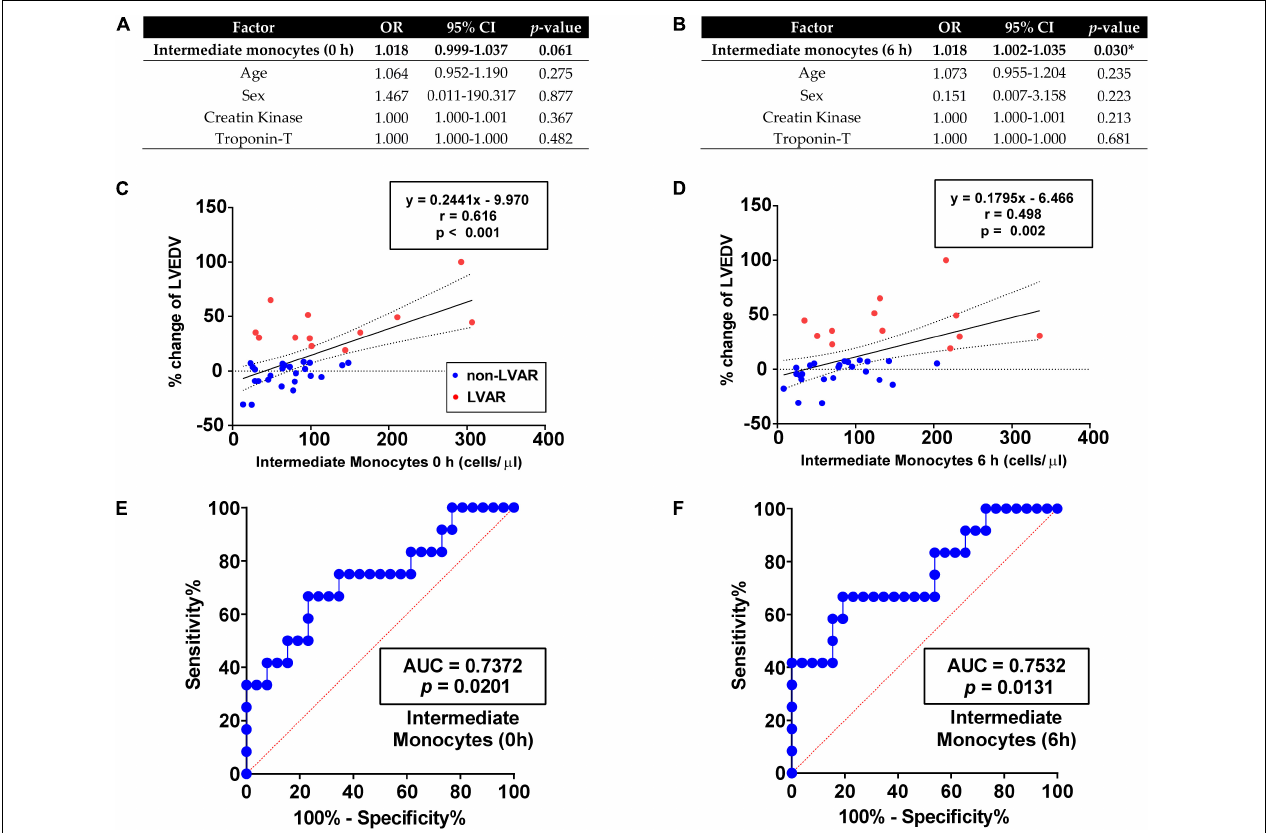
FIGURE 3 | Correlation analysis of the level of intermediate monocytes with LVAR. (A,B) Multivariate logistic regressions analysis of intermediate monocytes measured in PB at 0 h (A) and 6 h (B) , using age, sex, creatine kinase and troponin-T as cofactors. (C,D) Linear regression curves analysis using the percentage of change in LVEDV of non-LVAR (blue dots, n = 26) and LVAR (red dots, n = 12) patients as dependent variable and intermediate monocytes level at 0 h (C) or 6 h (D) as independent factor. (E,F) ROC analysis with the AUC (values given on the graphs) indicating sensitivity and specificity of level of intermediate monocytes at 0 h (E) or 6 h (F) to predict LVAR. Multivariate logistic regression, linear regression and ROC analysis were performed. (*) Indicates significance at p < 0.05. AUC, area under the curve; CI, confidence interval; LVAR, left ventricle adverse remodeling; LVEDV, left ventricular end-diastolic volume; OR, odds ratio; PB, peripheral blood; ROC, Receiver-operating